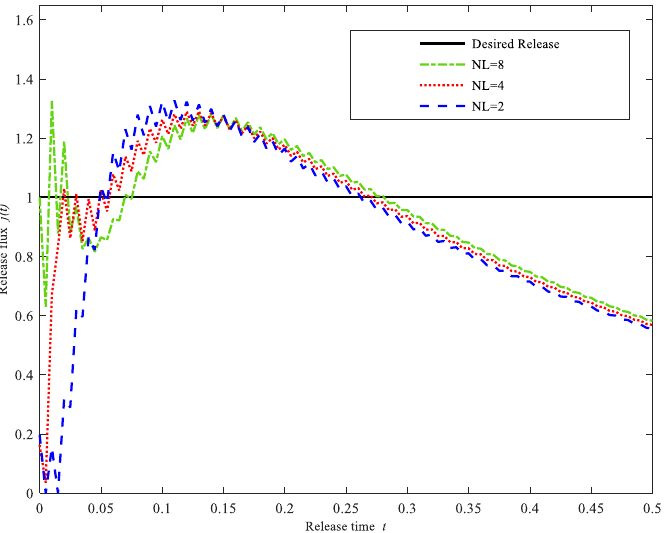
Figure 4. Drug Release profiles for different layers NL = 2, 4, 8. (Case 1).